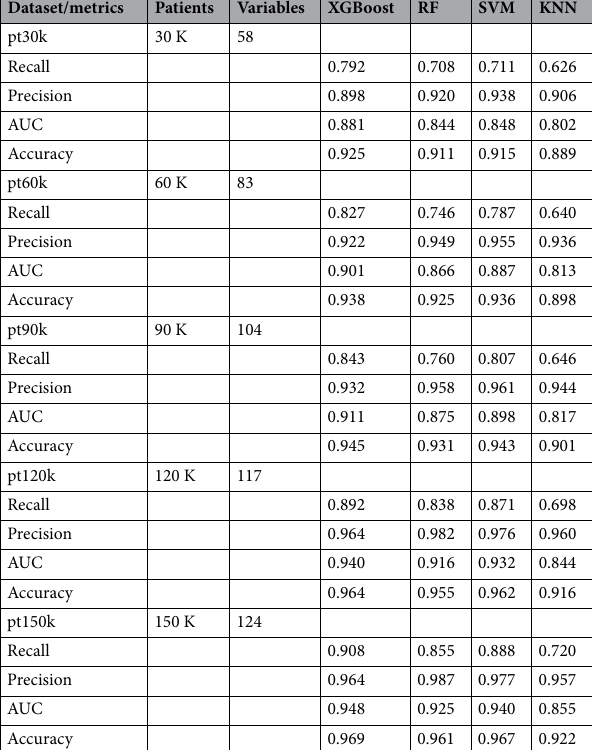
Table 2. Continuous update of patient datasets and improvement of XGBoost base models for stroke risk prediction in the simulated learning health system. Initial dataset: 30 K patients; 4 data updates, each with additional 30 K patients. The XGBoost base model was also compared to RF, SVM and KNN base models at the time of each data